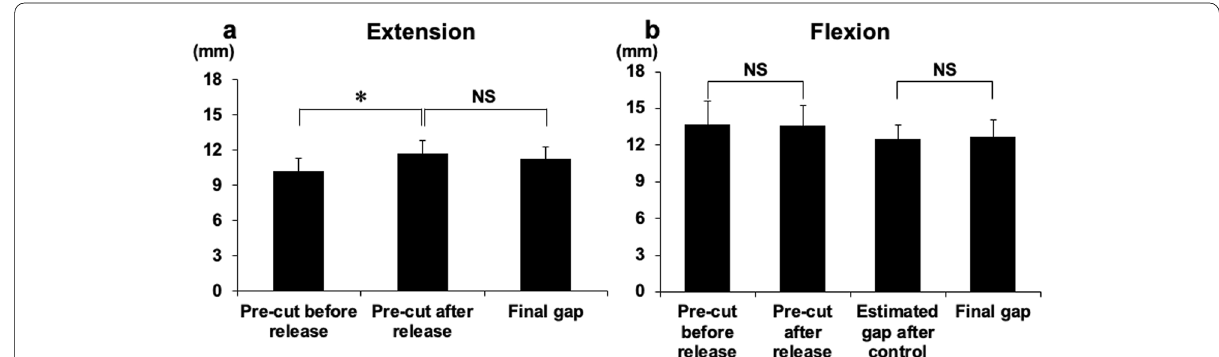
Fig. 4 Changing of extension and flexion gaps with PS PCT and trial components. The component gaps (CGs) with PS PCT before and after the release of femoral intercondylar notch capsule, and the final CGs with femoral trial component were examined at extension ( a ). The CGs at flexion with PS PCT before and after the capsular release were also examined; then, the estimated final CGs after gap control (flexion CGs with PS PCT minus the gap control amount) and actual final CGs at flexion were compared ( b ). (* P < 0.01). PS PCT, posterior-stabilised pre-cut trial